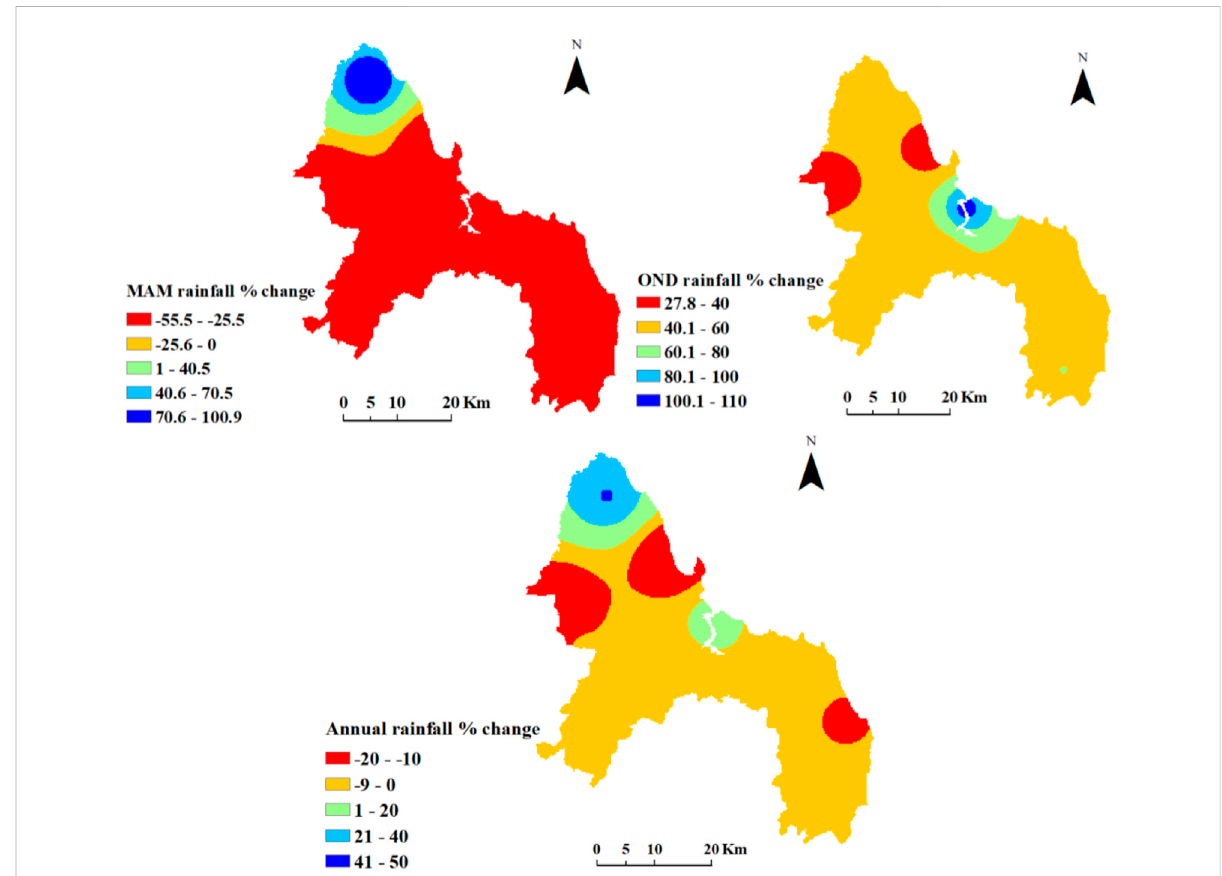
FIGURE 6 Spatial distribution of percentage change in rainfall at a season MAM, OND, and annual